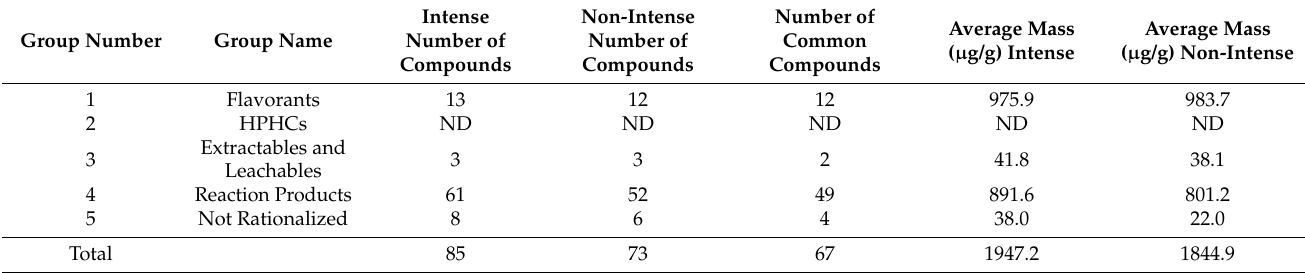
Table 11. Summary of Non-Targeted Analyses in Aerosol for Virginia Tobacco 5.0% Using Two Puffing Regimens. Group